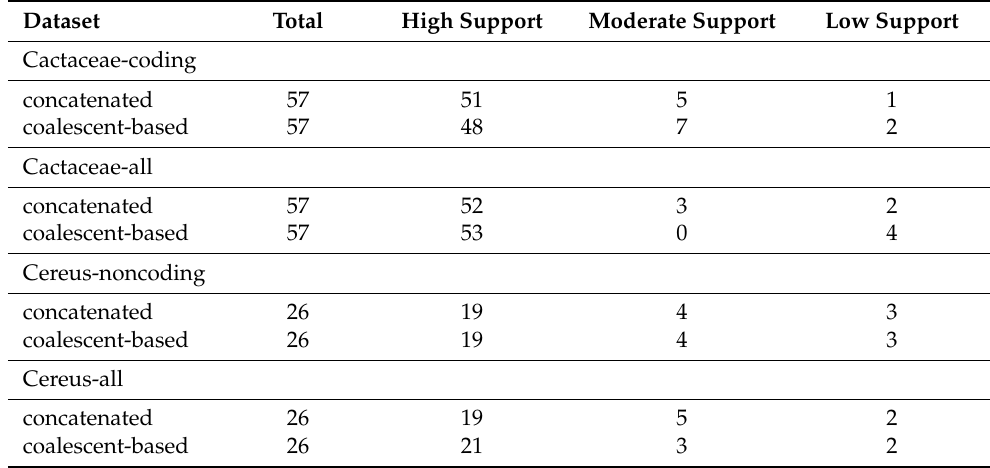
Table 2. Node support in the phylogenetic trees inferred from the Cactaceae and Cereus datasets, using different sub-datasets (coding, noncoding, and all sequences) and phylogenetic approaches. Branch support values of coalescent (LPP) and concatenated (BS) trees were classified as high (>0.95, >95), moderate (0.95–0.70, 95–70), or low (<0.70, <70),